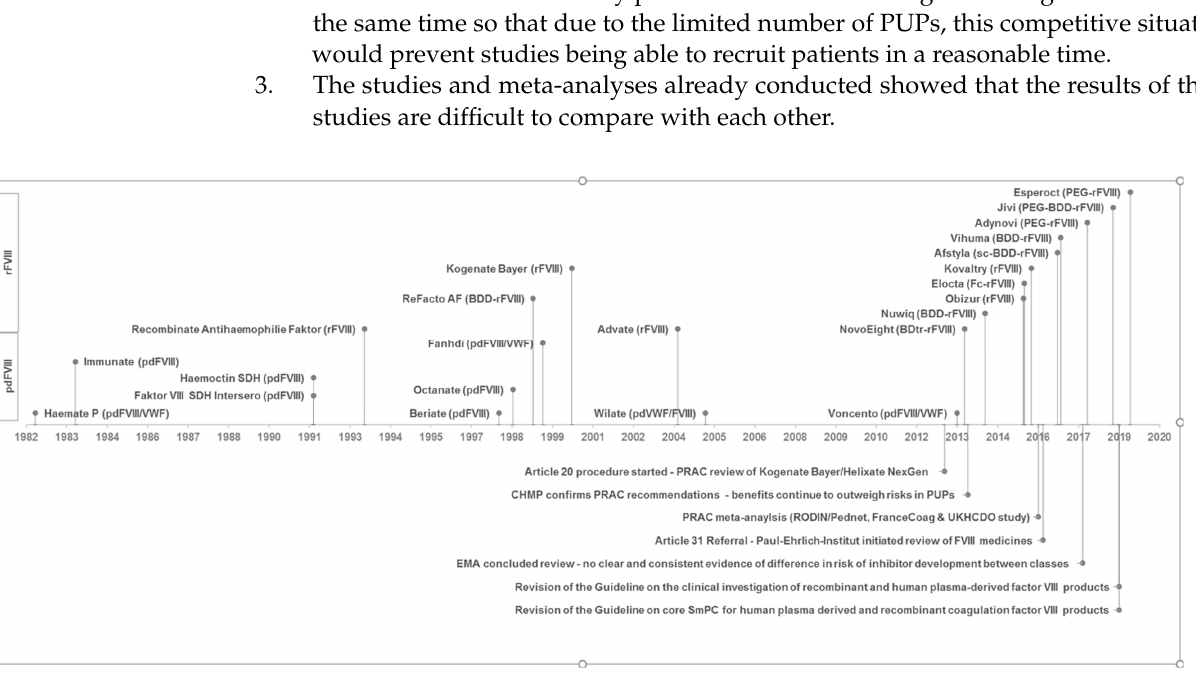
Figure 1. Time relationship between coagulation factor VIII (FVIII) product approval and triggered regulatory procedures for investigating the inhibitor incidence. License dates of human plasma-derived FVIII products (pdFVIII) and recombinant FVIII products (rFVIII) with marketing authorisation valid in Germany according to [18]are shown in the lower and upper area above the timeline. Qualitative product description is also given in brackets. VWF: von Willebrand factor, sc: single-chain, BDD/BDtr: B-domain deleted/truncated, PEG: PEGylated, Fc: Fc fusion protein.